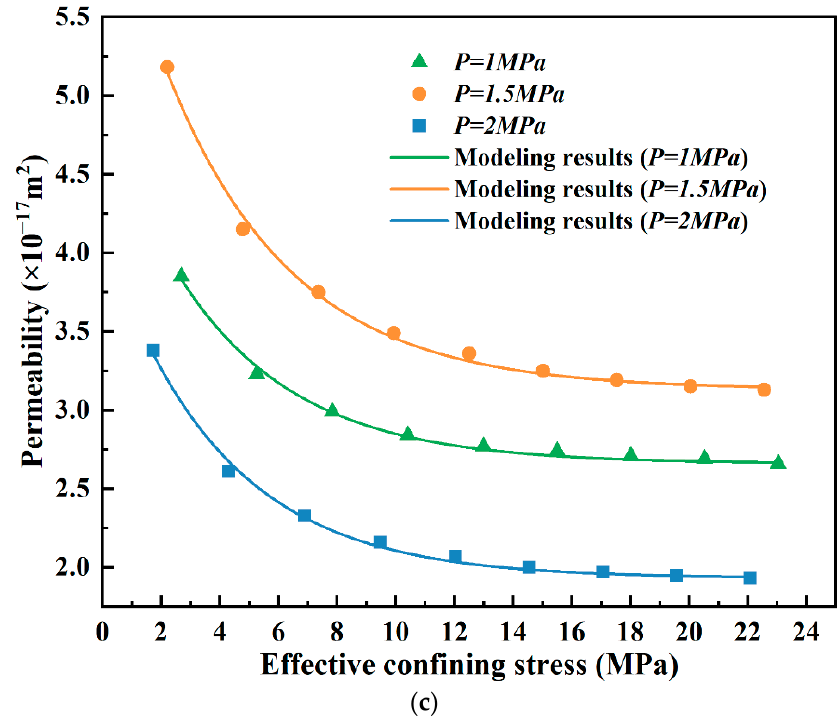
Figure 13. Permeability of the sandstone samples under different effective confining stresses and pore pressures, and modeling results from the proposed model in this study (( a – c ) are the initial confining pressure of 15 MPa, 20 MPa, and 25 MPa, respectively). Table 3. Parameters used for data fitting.